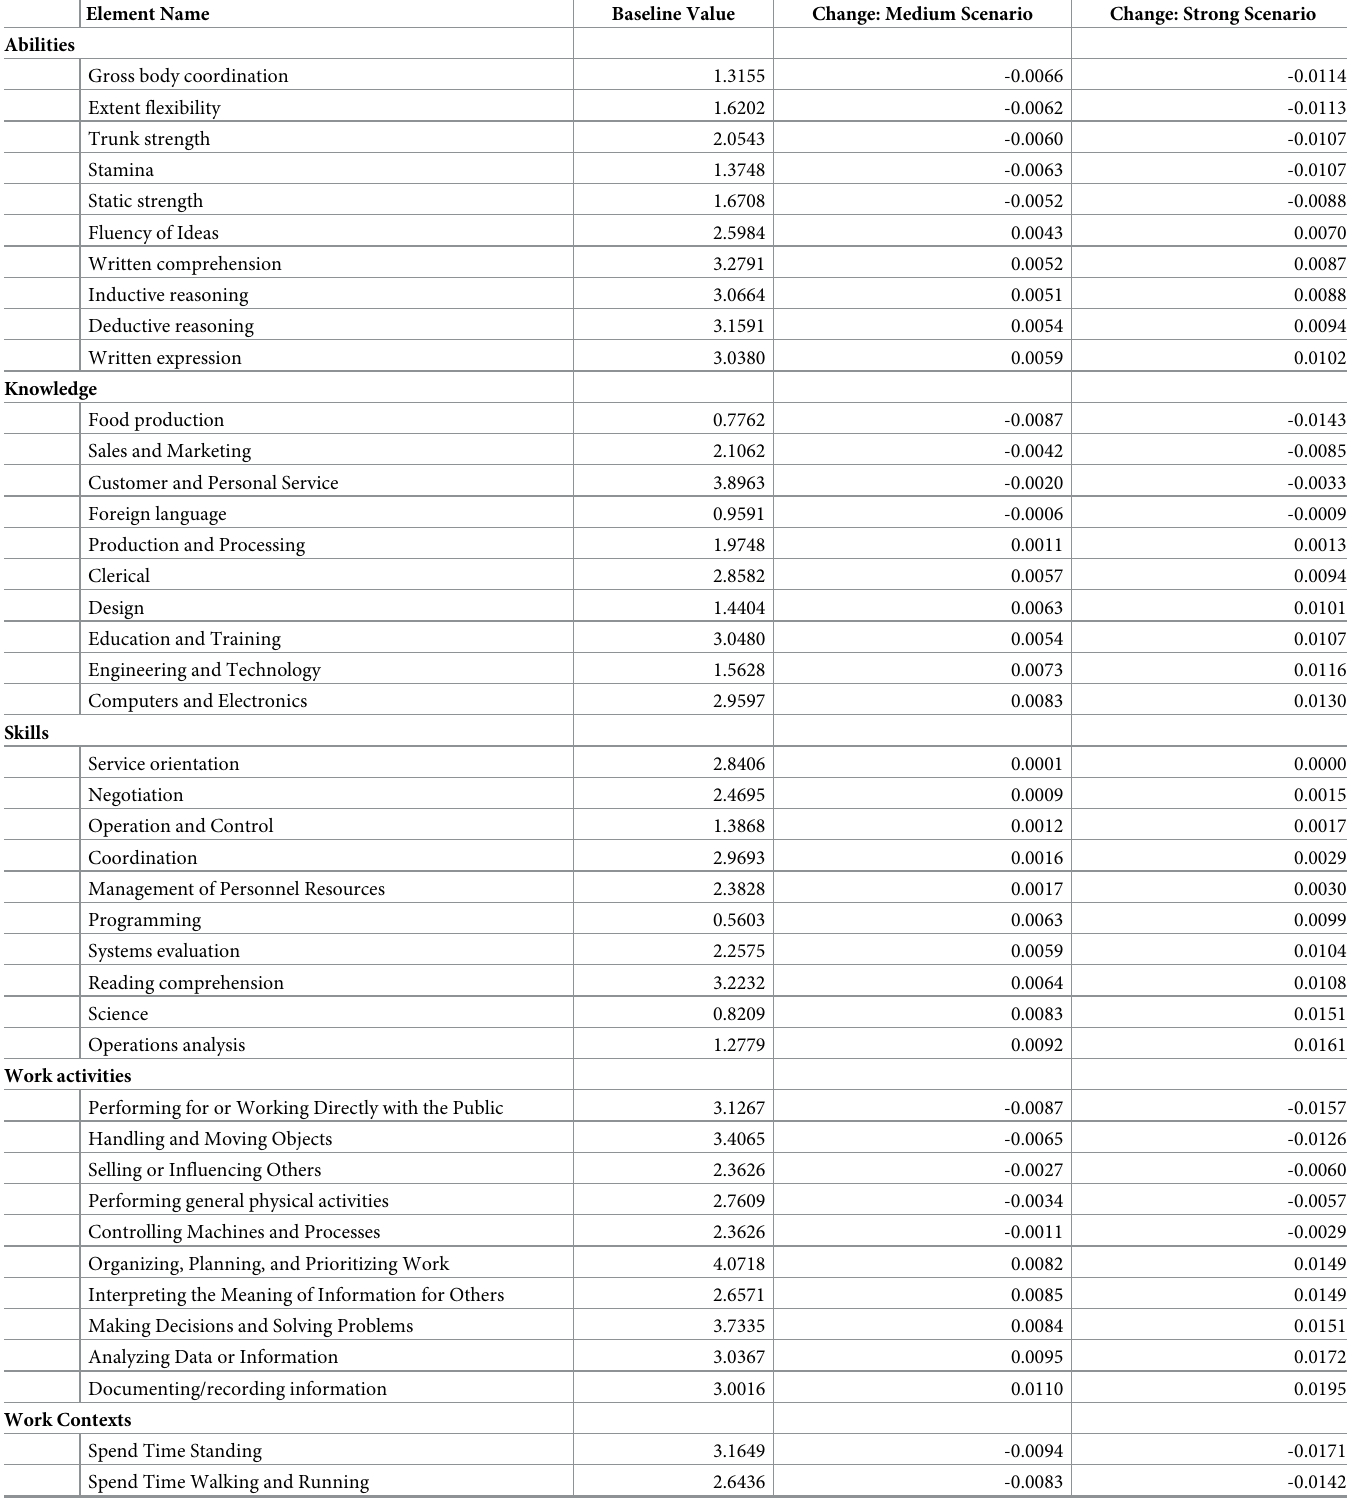
Table 2. Projected changes in importance of occupational elements by element